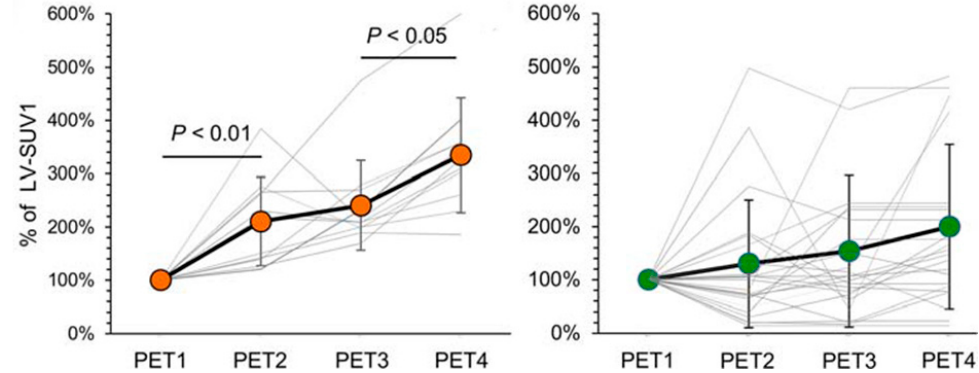
Figure 2. Myocardial FDG uptake significantly increases in HD patients with late treatment-related cardiac abnormalities, defined as electrocardiographic or echocardiographic abnormalities ( left panel ) compared to those patients without late therapy-induced cardiotoxicity ( right panel ). FDG PET/CT scans: the baseline at staging (PET1); a negative interim scan during chemotherapy (PET2),